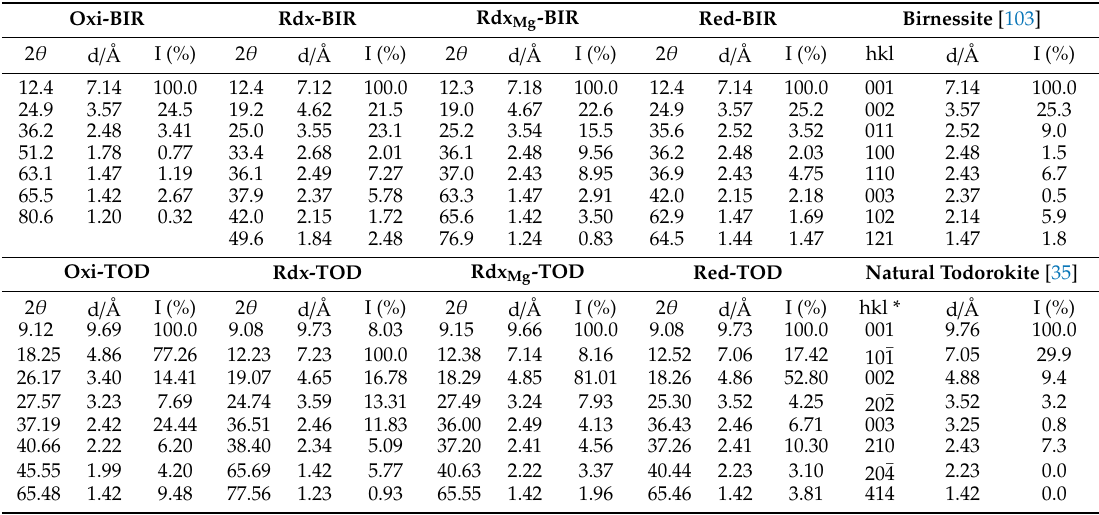
Table 1. XRD data for the synthesized birnessite and todorokite with respect to the reference data. Oxi-BIR Rdx-BIR Rdx Mg